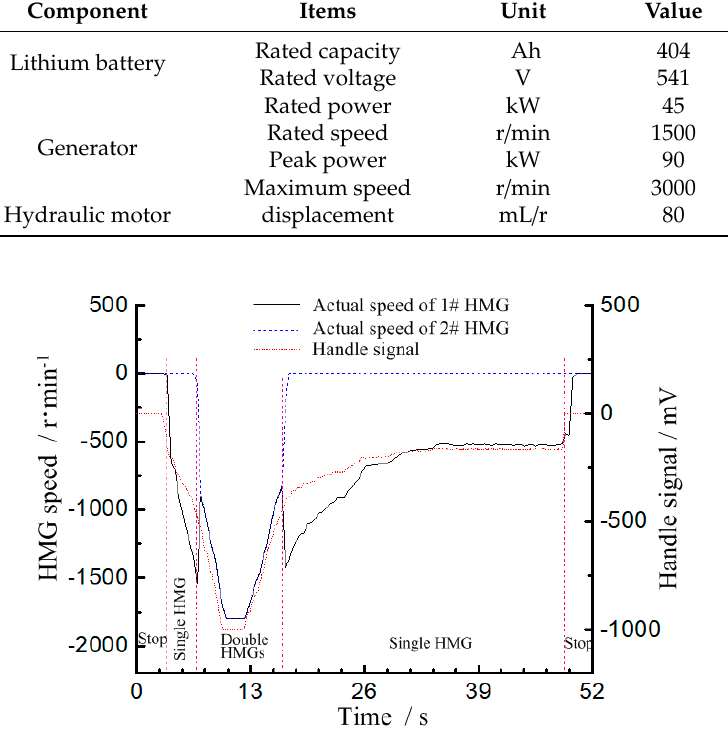
Figure 9. Relationship between motor speeds and handle signal.